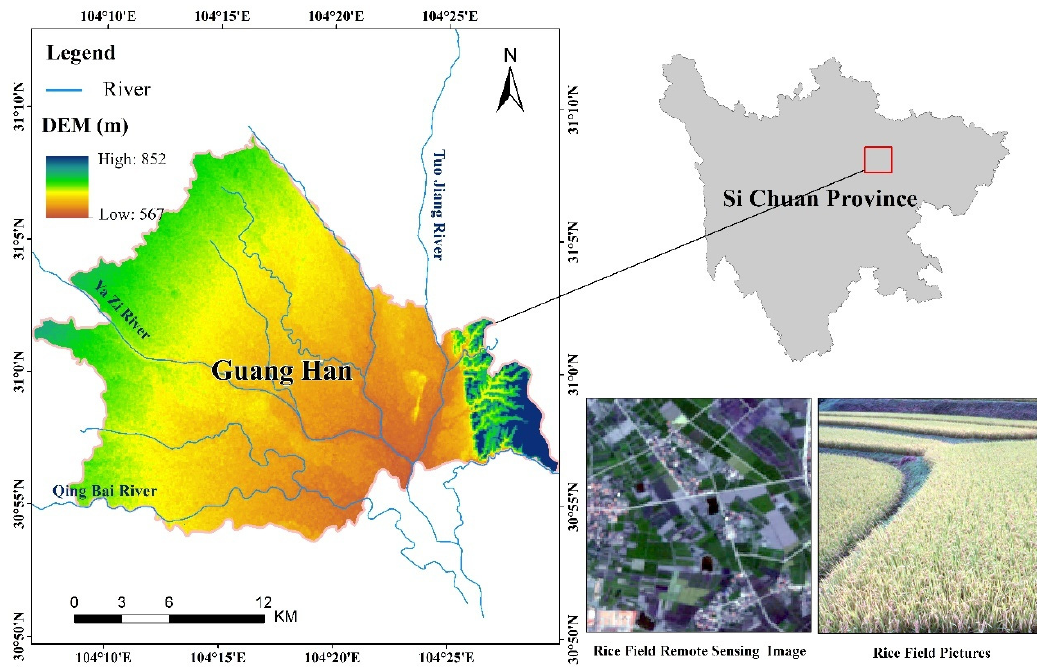
Figure 1. Location of the study area. Table 1. Phenological stage of rice growth in the study area.